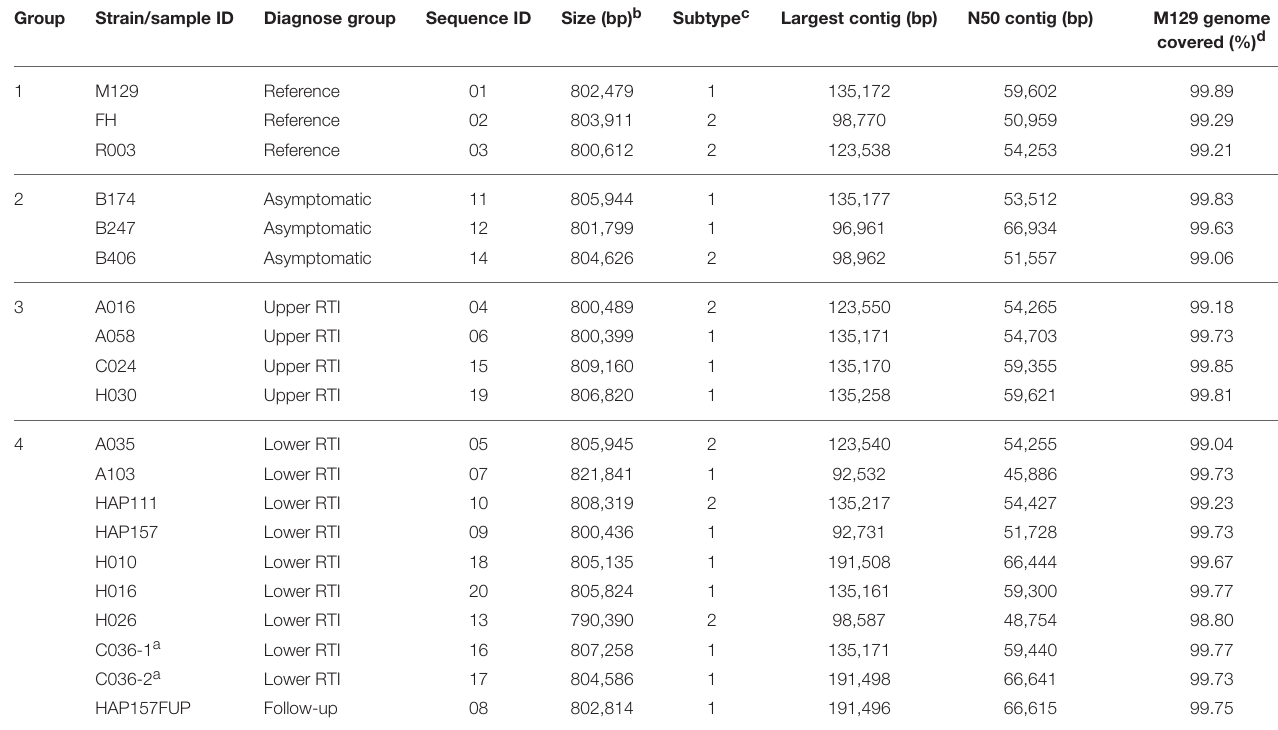
TABLE 1 | Sample ID, patient information, strain information and de novo assembly information.